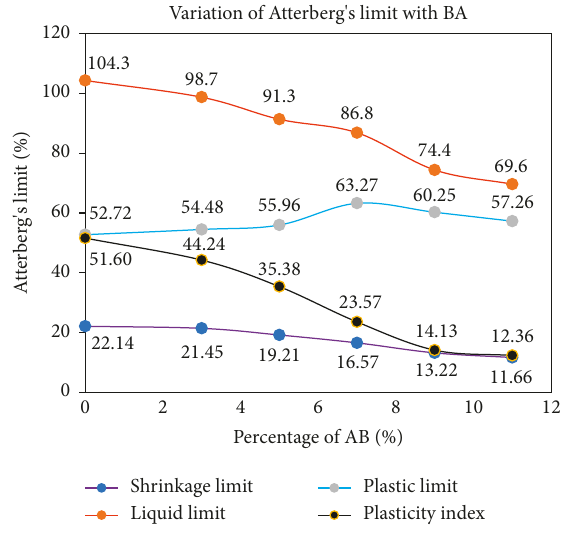
Figure 4: Effect of BA on Atterberg’s